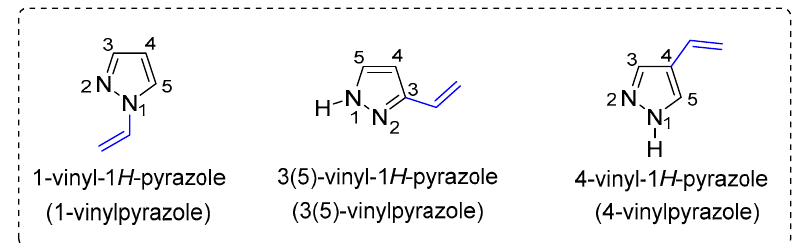
Figure 1. Structures of 1-vinylpyrazole, 3(5)-vinylpyrazoles, and 4-vinylpyrazole. For sake of simplicity, throughout the manuscript, the nomenclature 1-vinylpyrazole is adopted instead of 1-vinyl-1 H -pyrazole.